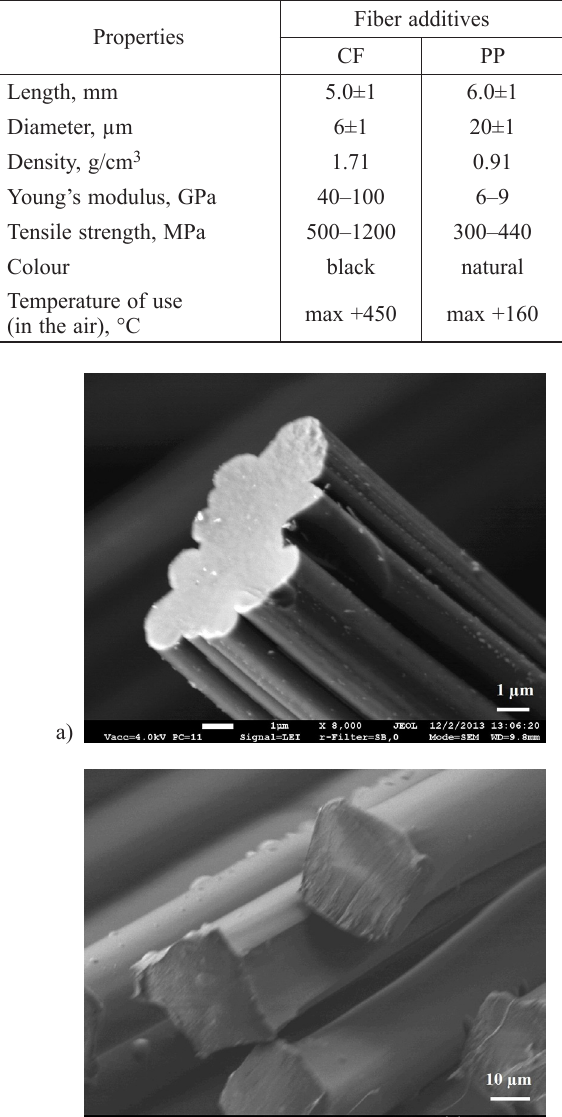
Table 1. Technical characteristics of CF and PP fibers